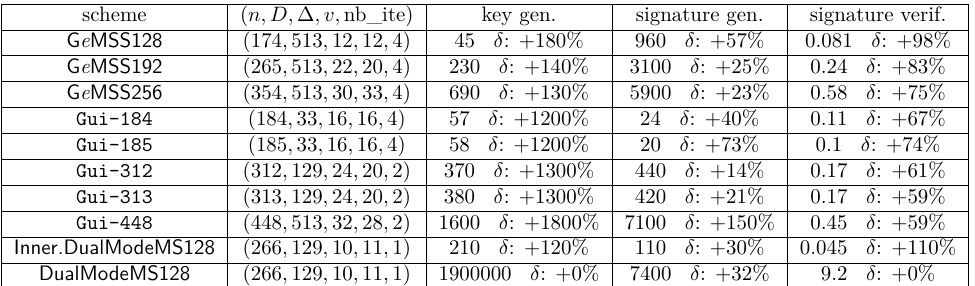
Table 29: Number of mega cycles (Mc) for each cryptographic operation with our li- brary for a Haswell processor (ServerH), followed by the speed-up between the best implementation provided for the NIST submissions versus our implementation. For exam- ple, 45 δ : +180% means a performance of 45 Mc with MQsoft , and a performance of 45 × 2 . 8 = 130 Mc for the NIST